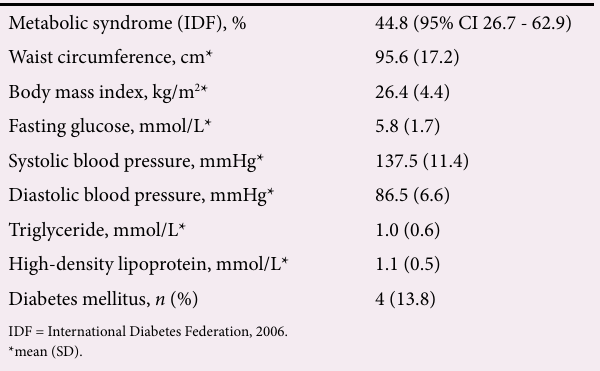
Table 1. Metabolic profile of the study participants treated with clozapine ( N